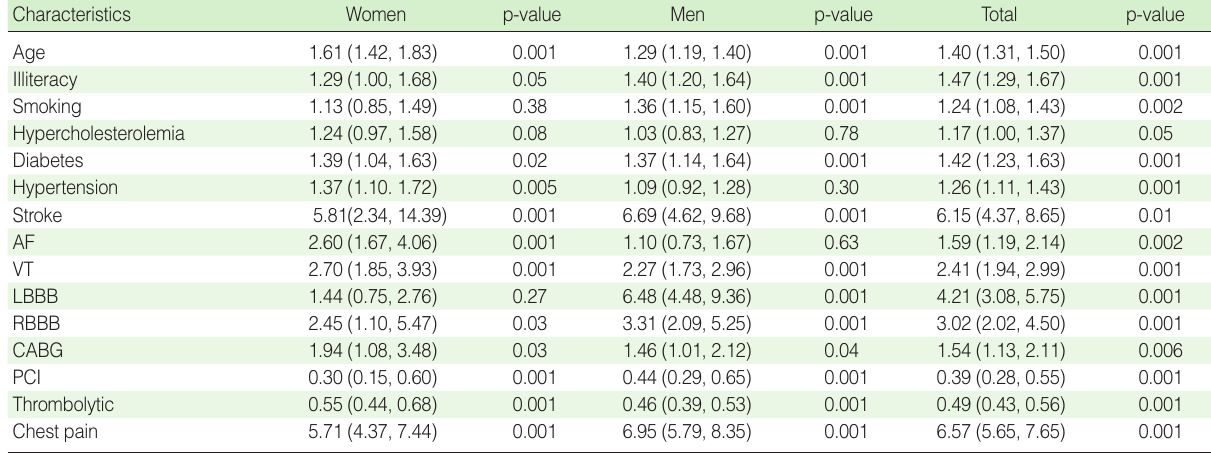
Table 3. Unadjusted odds ratio for risk factors for heart failure in men and women myocardial infarction patients Characteristics